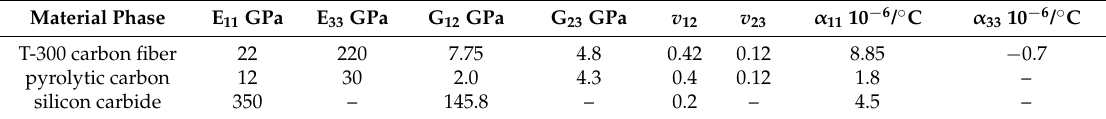
Table 2. Properties for each material phase.